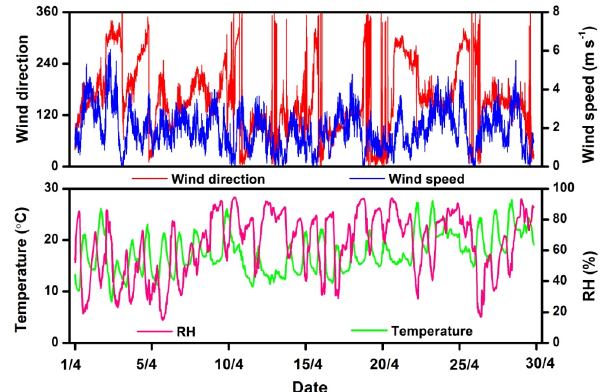
Figure 1. Series of 10min mean meteorological parameters over the entire